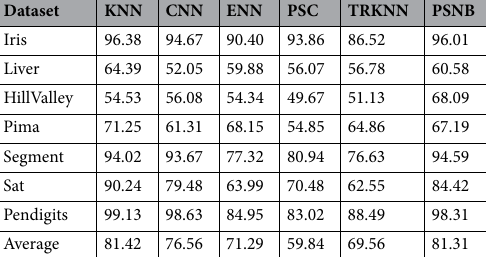
Table 4. Classification accuracy of stationary experiments.